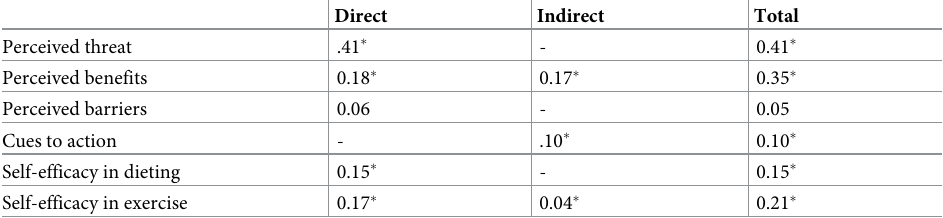
Table 3. The total, direct and indirect effect of Health Belief constructs on behavioral intention of weight management.